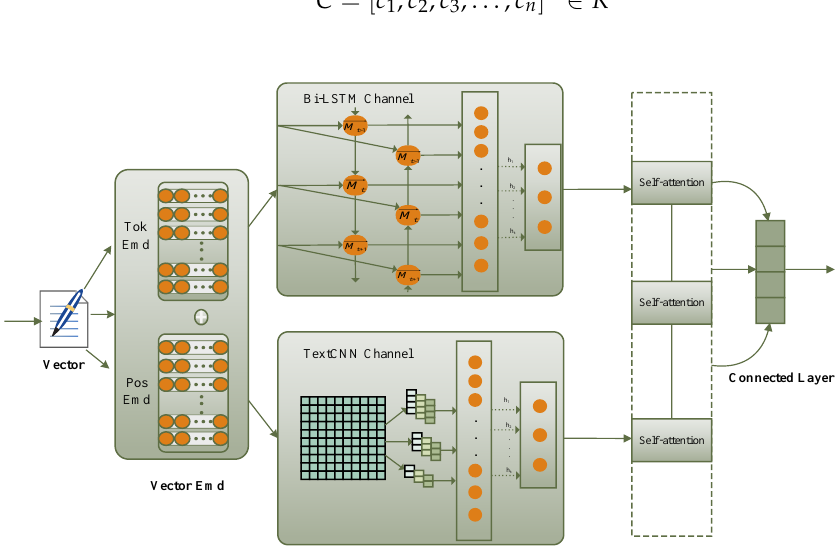
Figure 2. BLTCN-BLSTM multi-channel self-attention network